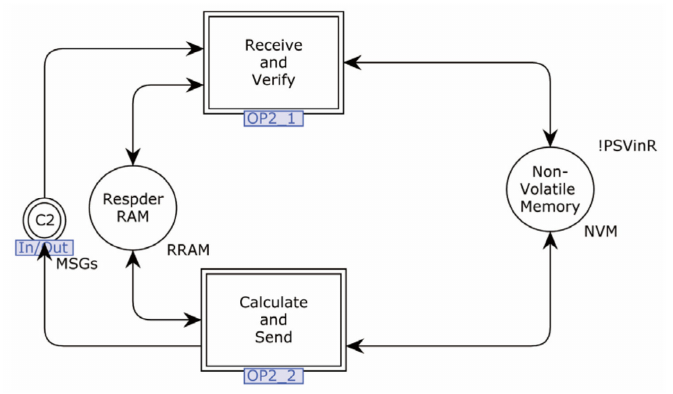
Figure 7. The second-layer model of Responder.